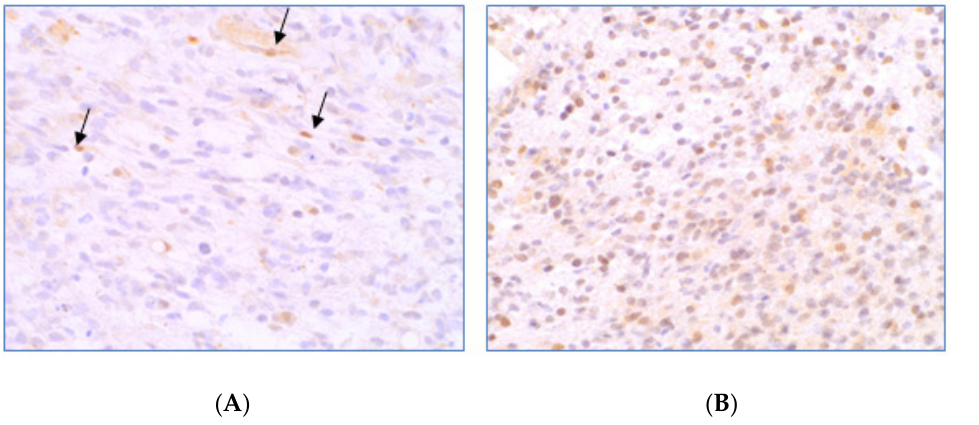
Figure 1. MGMT expression evaluated by IHC. ( A ) An example of a GBM with negative staining of MGMT protein. The arrows indicate internal positive control, namely inflammatory cells and endothelial cells. ( B ) An example of a GBM showing expression of MGMT protein.